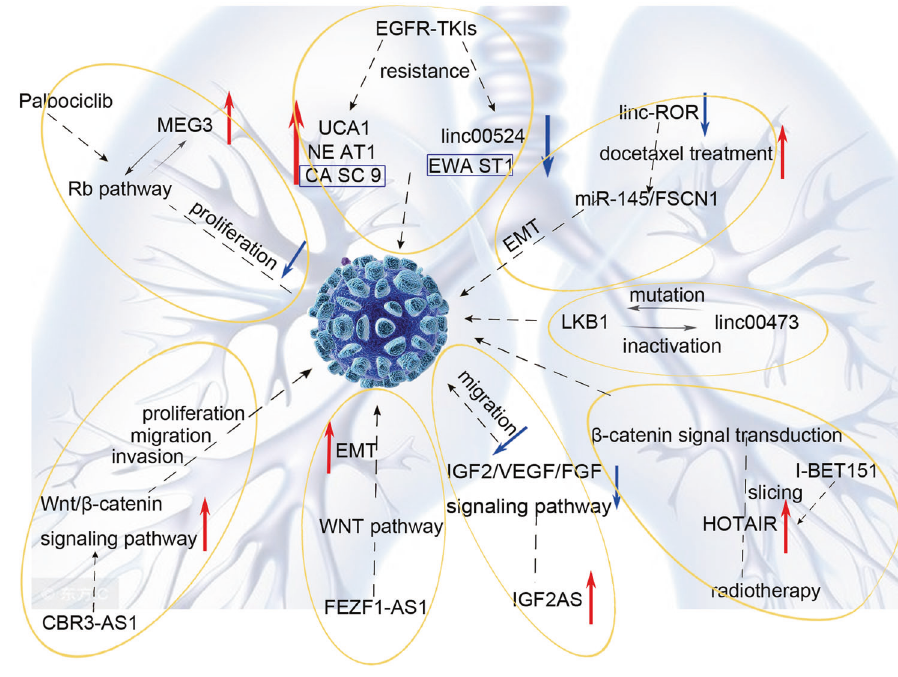
Fig. 3 Schematic of LncRNAs regulate signaling pathways regimen in NSCLC.